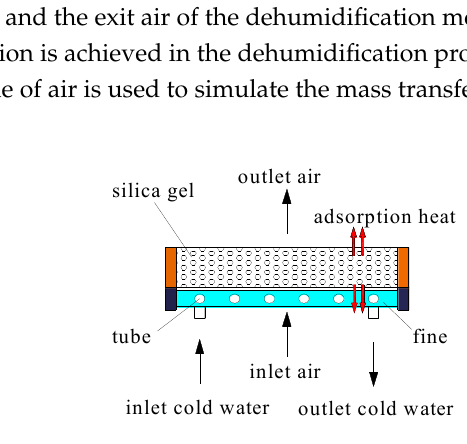
Figure 17. Heat and mass transfer model of dehumidification process.